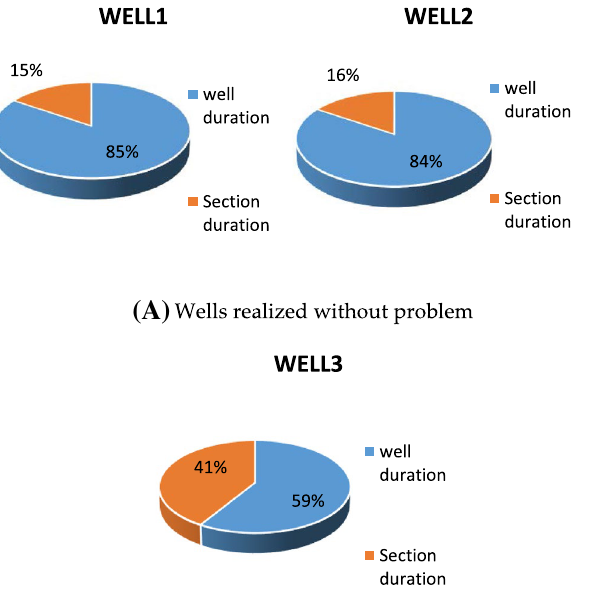
Fig. 1 9 ″ 5/8 section consumption time compared to hole well reali- zation